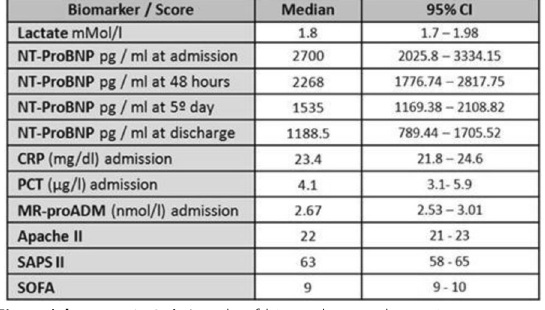
Fig. 1 (abstract 0125). Levels of biomarkers and severity